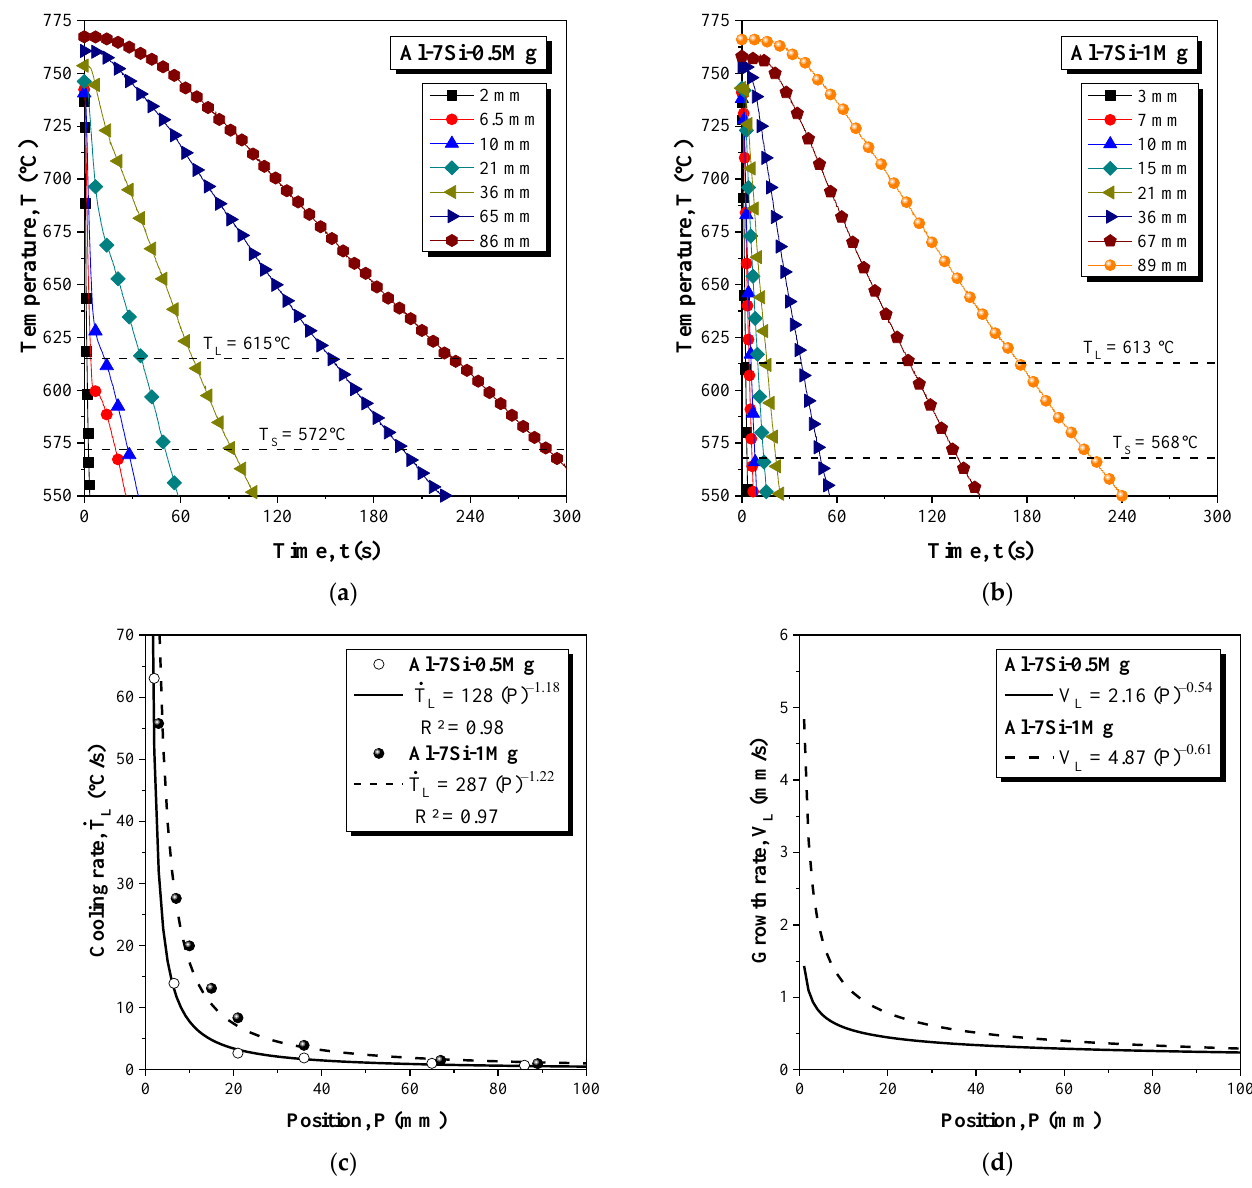
Figure 2. Cooling curves of the ( a ) Al-7Si-0.5Mg and ( b ) Al-7Si-1Mg alloys, and profiles of the ( c ) cooling rate and ( d ) growth rate along the length of the DS castings. Table 2. Si, Mg and Fe solute concentrations along the length of the directionally solidified castings. Element Alloy